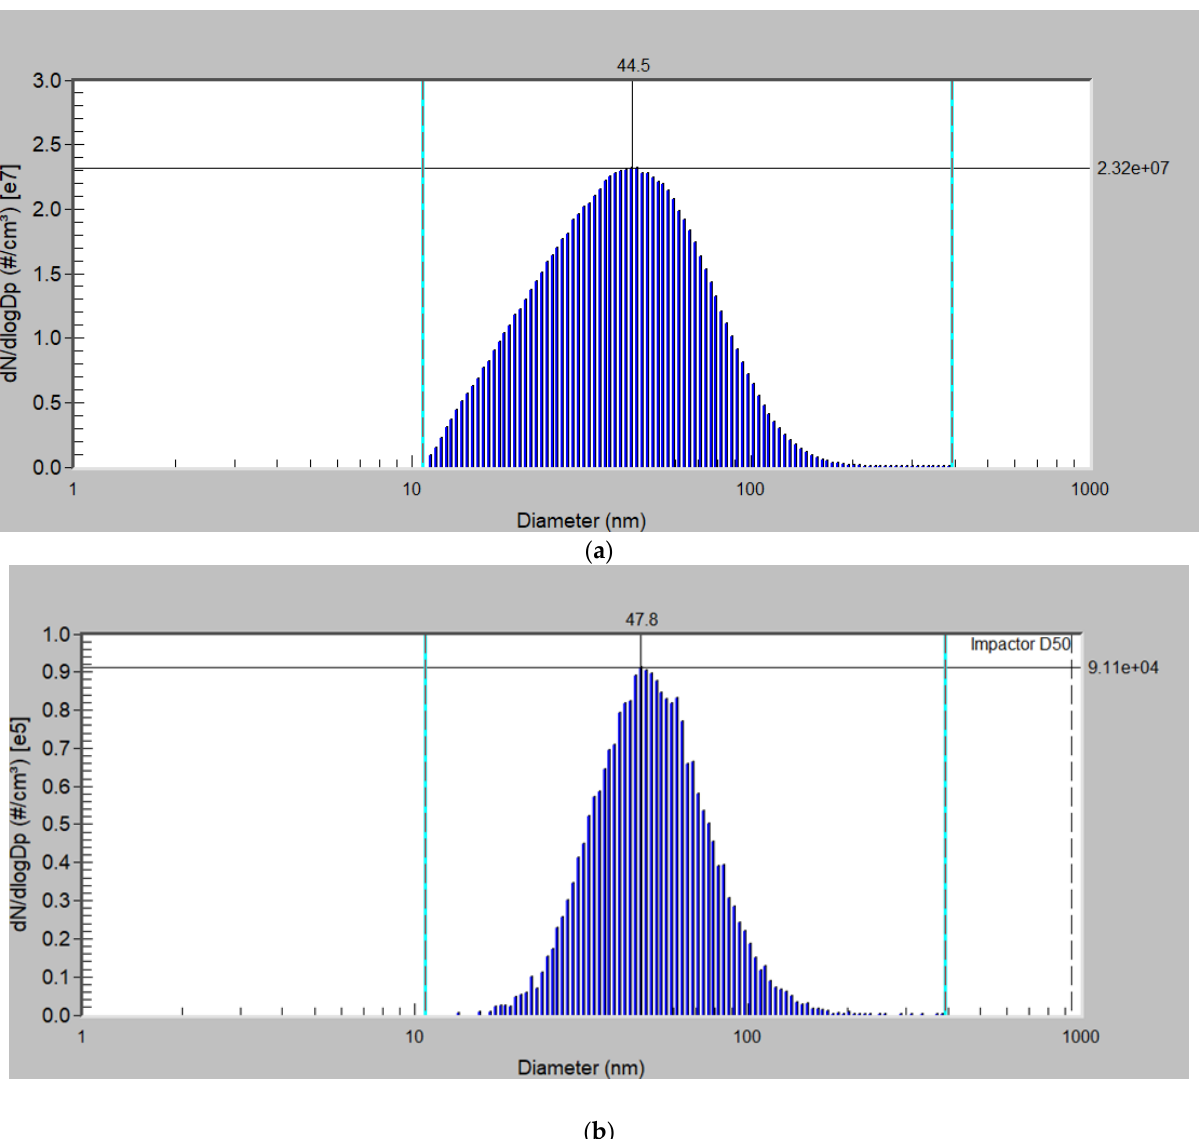
Figure 10. Filtration experiment measured by the differential mobility analyzer. ( a ) The aluminum sparked wire without a surgical mask as a filter. The concentration of nanoparticles produced by sparking was 2.32 × 10 7 particles at 1 cm 3 at size of 44.5 nm ( b ) Results of differential mobility analyzer (DMA) from aluminum sparked wire with a filter from a commercially available surgical mask. Concentration of nanoparticle produced by sparking was 9.11 × 10 4 particles at 1 cm 3 at size of 47.8 nm.